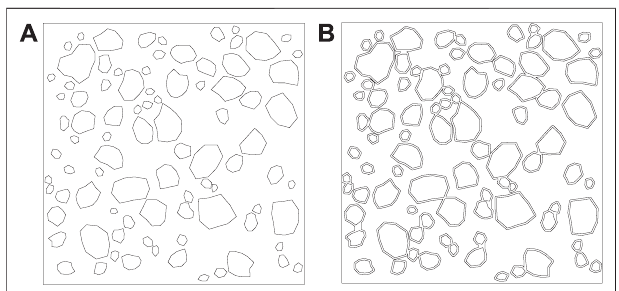
FIGURE 3 | Generation ofthe three-phase concrete: (A) rock aggregate model and (B) three-phase